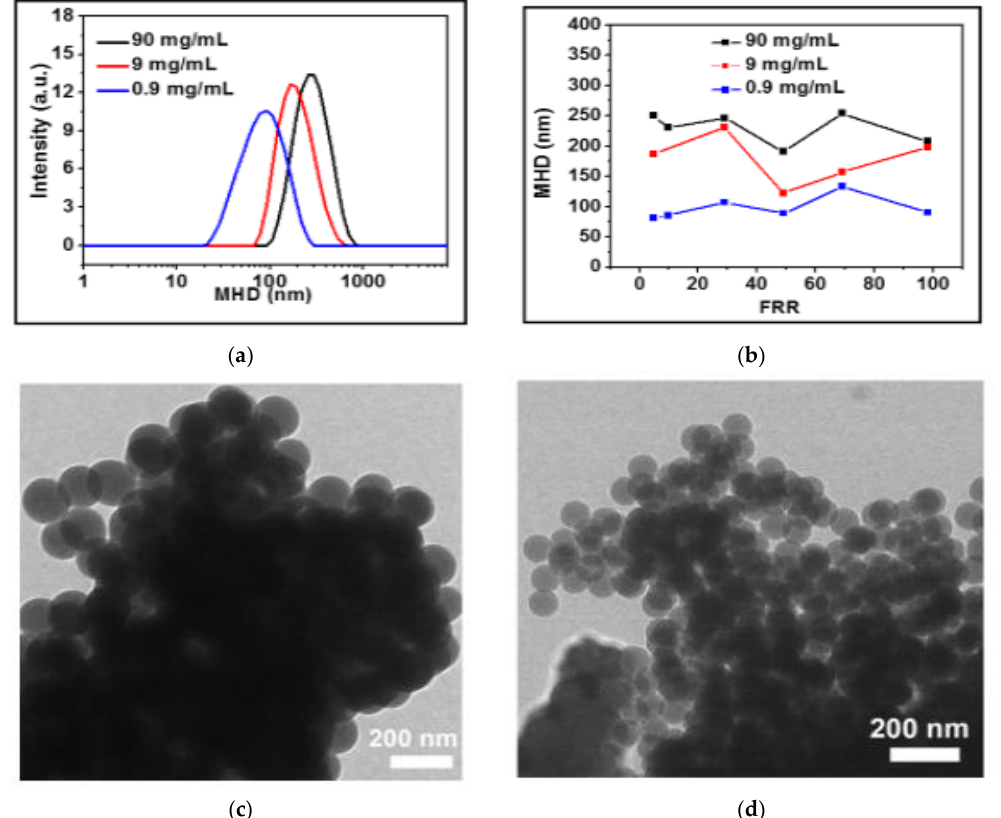
Figure 4. ( a ) DLS spectra of liposome solutions produced inside 45° chips at FRR = 5, at three different lipids concentrations; ( b ) plot of the Z-average MHD versus the FRR at three different lipids concentrations inside 45° chips. Transmission electron microscopy (TEM) pictures of vesicles obtained through a 45° chip; ( c ) at FRR = 30 and lipids concentration of 90 mg/mL; and ( d ) at FRR = 70 and lipids concentration 0.9 mg/mL.